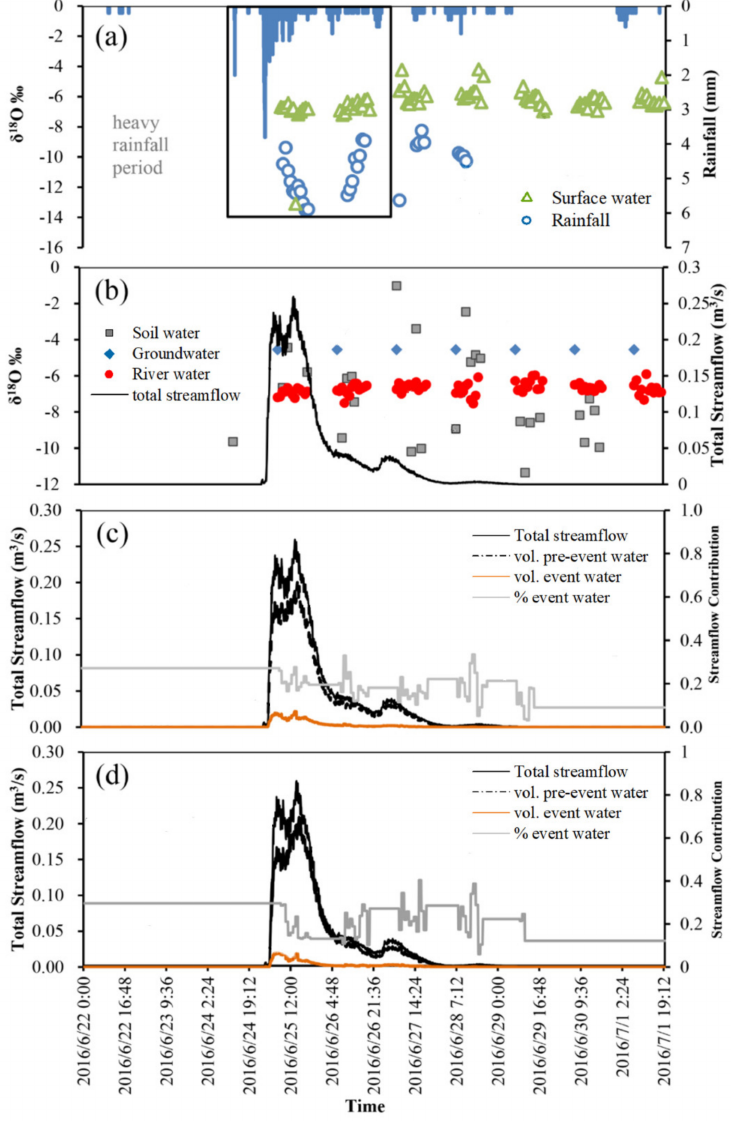
Figure 3. ( a ) Rainfall and surface water δ 18 O composition during the plum rainstorm and rainfall amount. ( b ) δ 18 O values for soil water, groundwater and streamflow. ( c ) Discharge and results of the two-component mixing model, using δ 18 O for pre-event and event waters as a constant. ( d ) Discharge and results of the two-component mixing model, using temporal variation in δ 18 O in